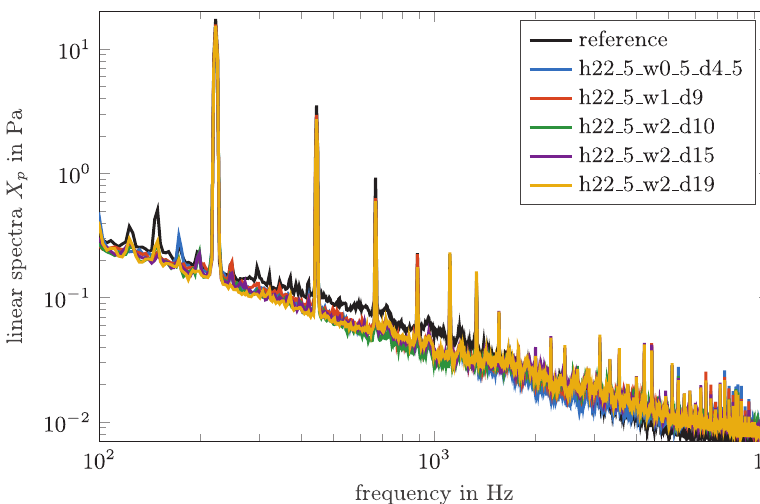
Figure 6. Wall-pressure fl uctuations on the suction side of the fan.